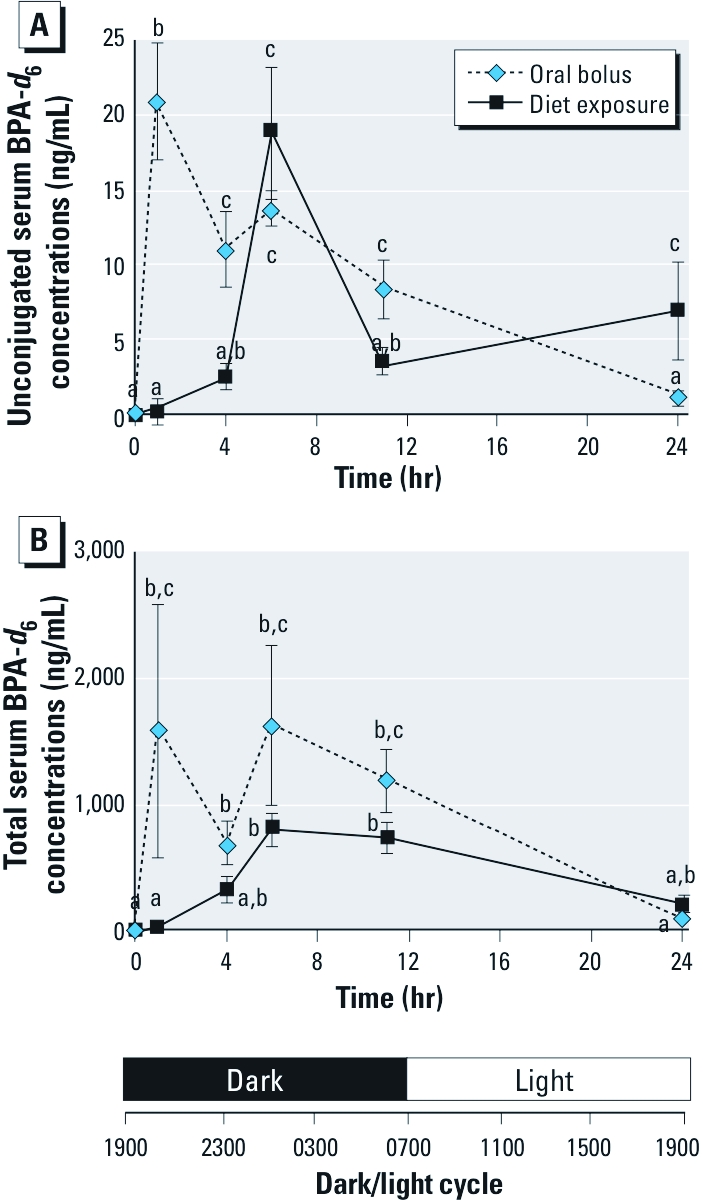
Arithmetic plot of the mean (± SE) serum concentrations of unconjugated BPA‑d6 (A) (and the total BPA‑d6 serum concentrations (B) versus time and versus night/day cycle after a single oral bolus of BPA‑d6 at 20 mg/kg BW or after exposure to BPA‑d6 at 100 mg/kg feed weight (13 mg/kg BW in the first 24 hr; see Figure 1) in mice. For the oral bolus, Cmax for unconjugated BPA‑d6 and total BPA‑d6 occurred 1 hr after the treatment (2000 hours). In contrast, Cmax was not obtained until 6 hr after treatment (0100 hours) in the diet-exposed group. Within each treatment group, values with different superscripts are significantly different (p < 0.05).